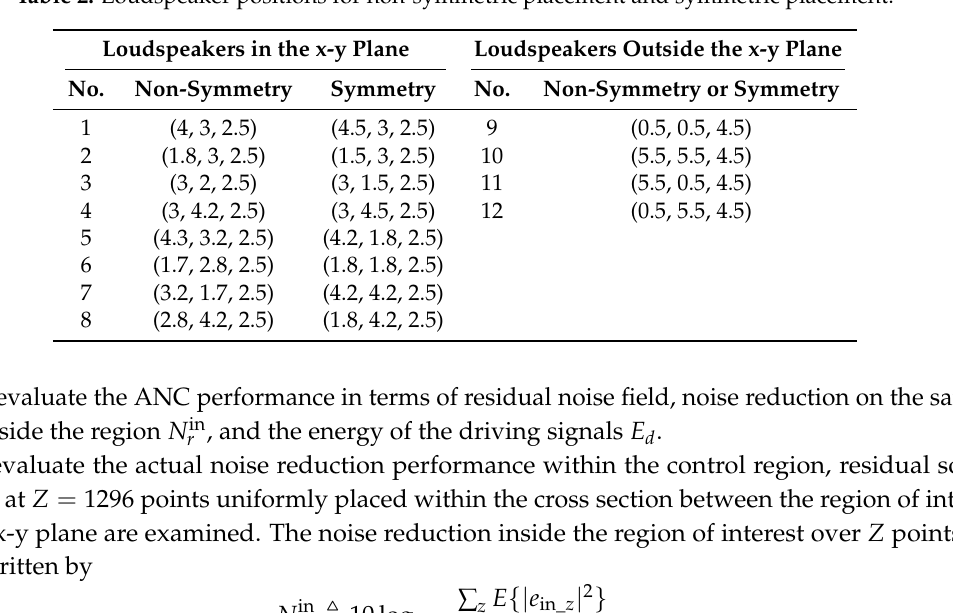
Table 2. Loudspeaker positions for non-symmetric placement and symmetric